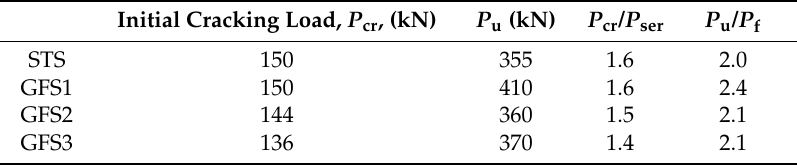
Table 4. Summary of test results.